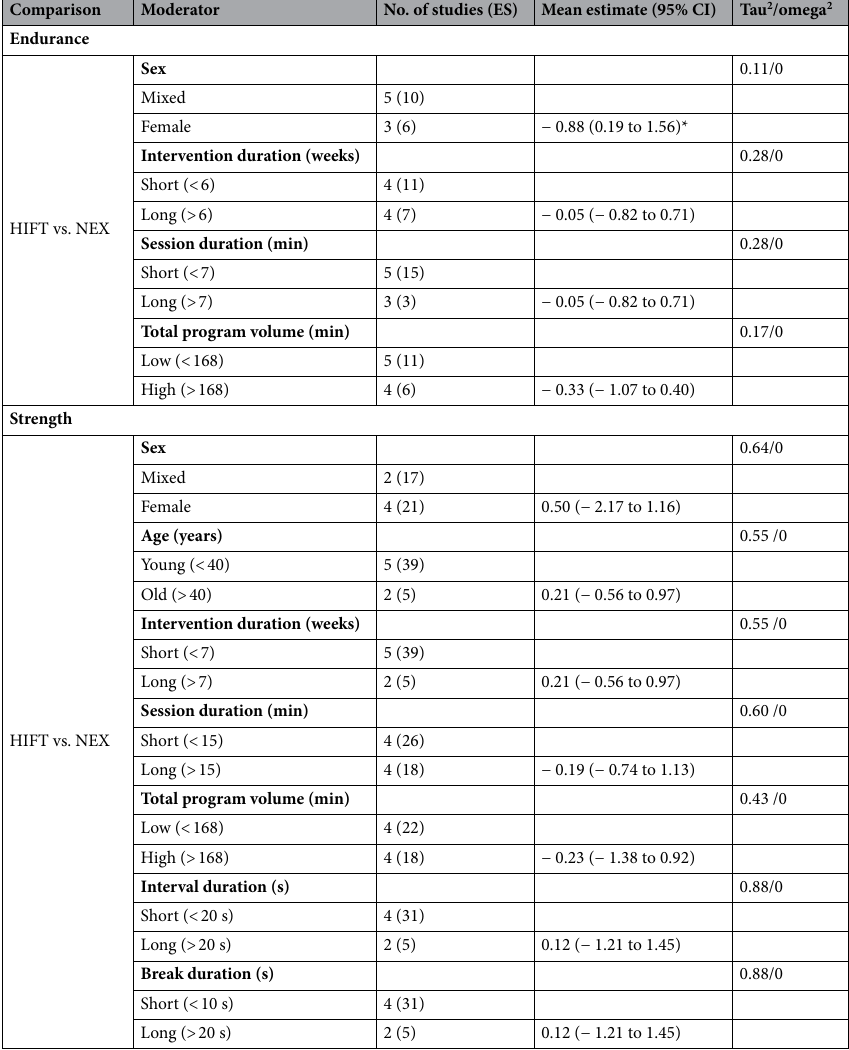
Table 3. Results of the moderator analysis. HIFT high-intensity functional training, NEX no exercise, HIIT high-intensity interval training, MCT moderate continuous training, no number, ES effect size, CI confidence interval. Asterisks mark statistical significance of a moderator level (p <